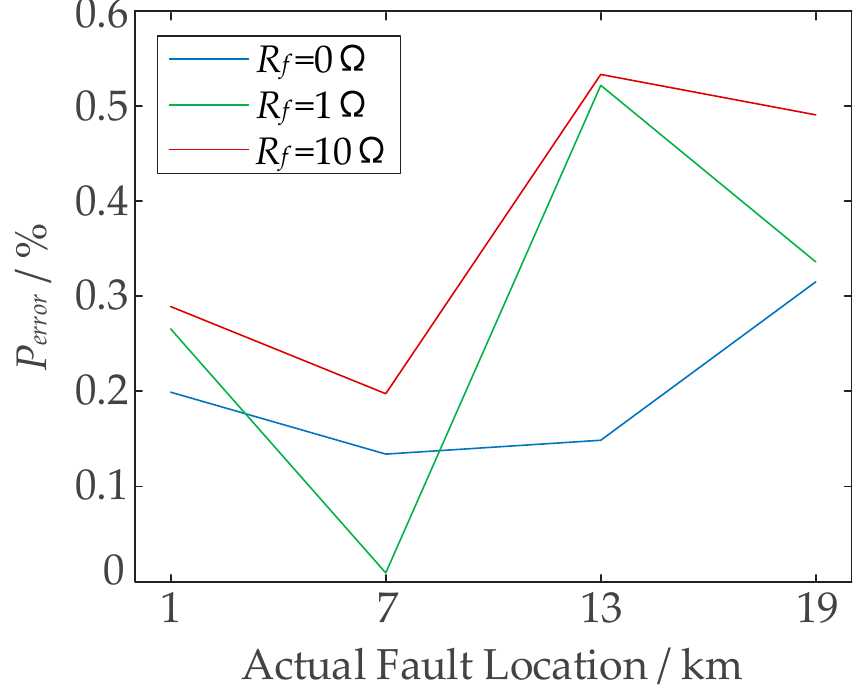
Figure 6. Simulation results for pole-to-pole short-circuit.